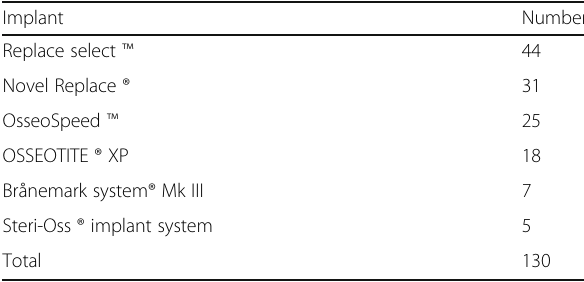
Table 1 Implant systems